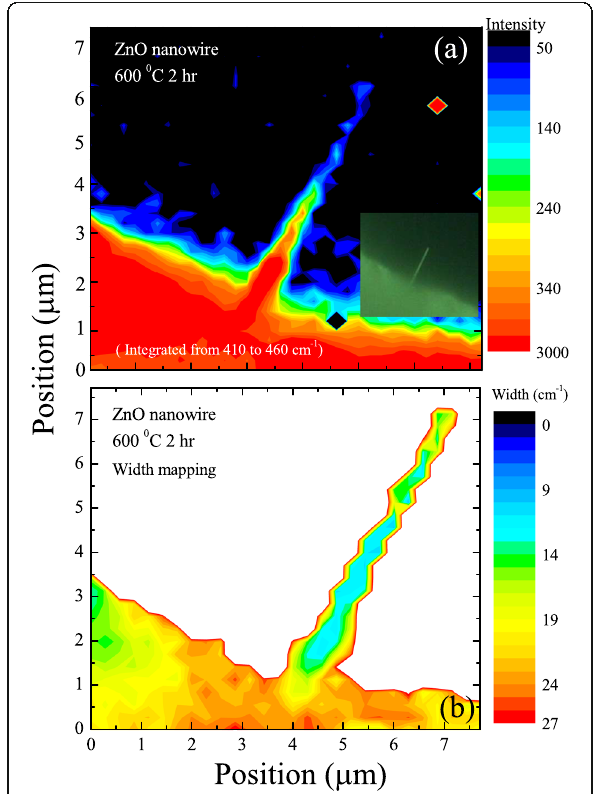
Fig. 6 a Raman intensities mapping of ZnO E 2 peak ranging from 410 to 460 cm − 1 and ( inset ) the corresponding optical image. b The corresponding selected area width mapping with a size of ~7.7 μ